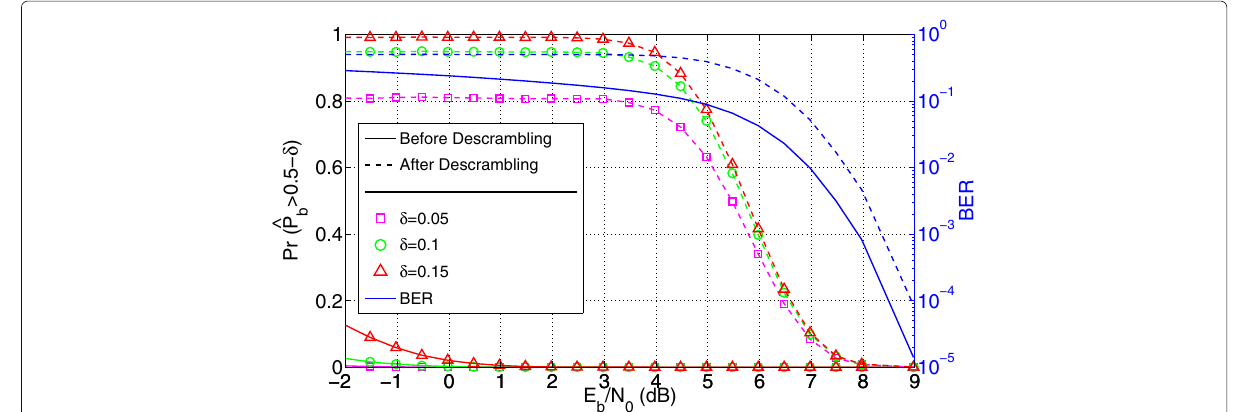
Fig. 2 New security metrics for a simple system where the outer code is a scrambler and the inner code is a BCH(127,64) code. BER curves are given (cid:3) (cid:2) ˆ P > 0.5 − δ curves are given with markers as indicated to identify the values of δ . Solid lines indicate the location in blue with no markers, and Pr b is before the outer coder, while dashed lines indicate the location is after the outer